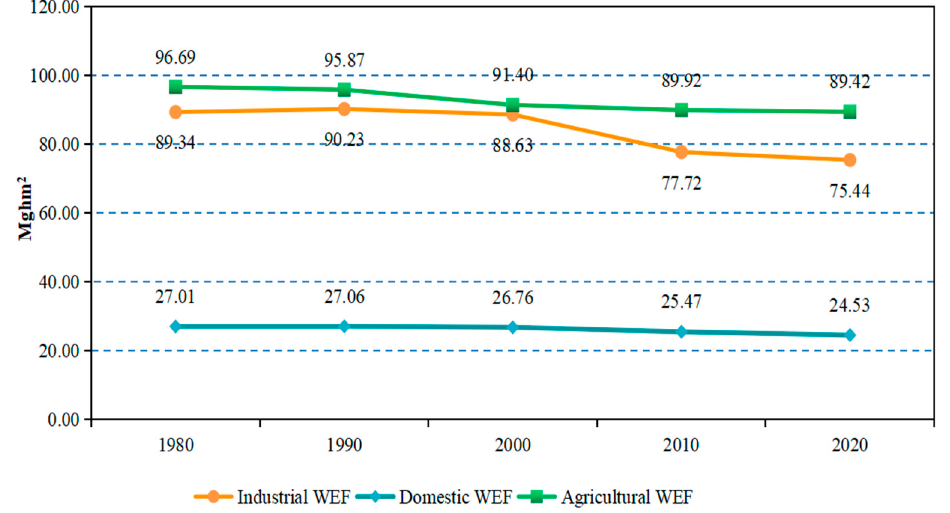
Figure 3. The WEF of traditional account in Japan during